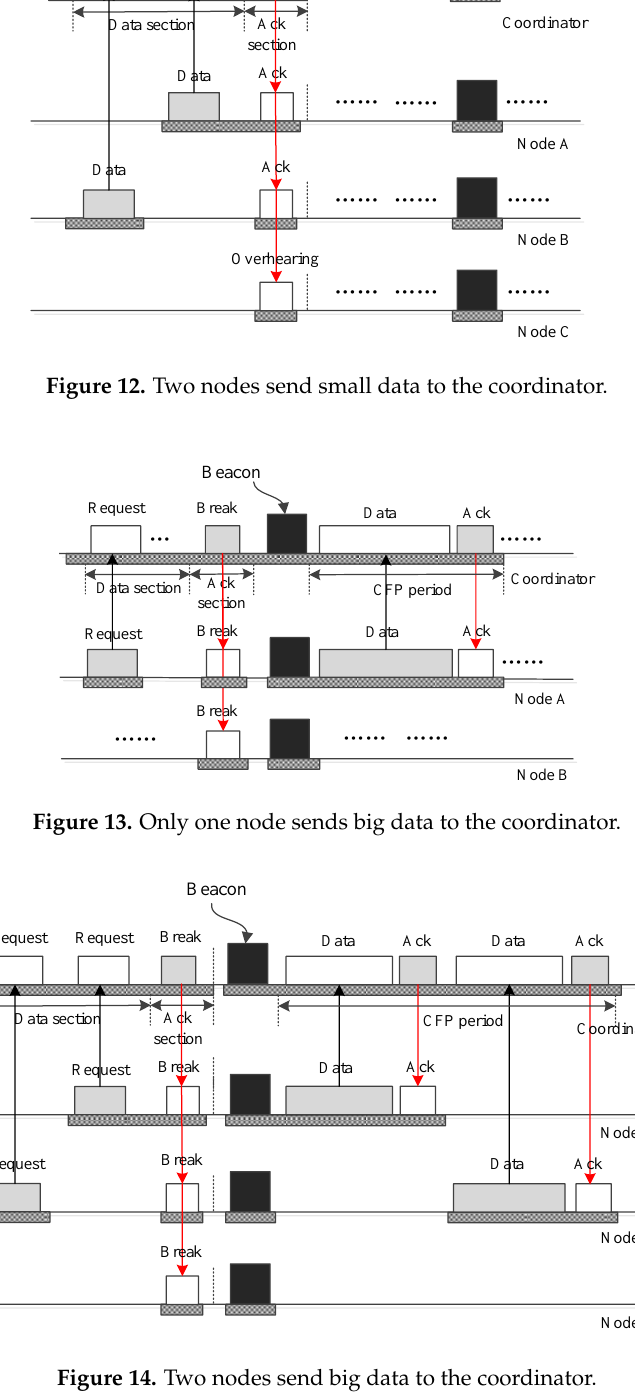
Figure 14. Two nodes send big data to the